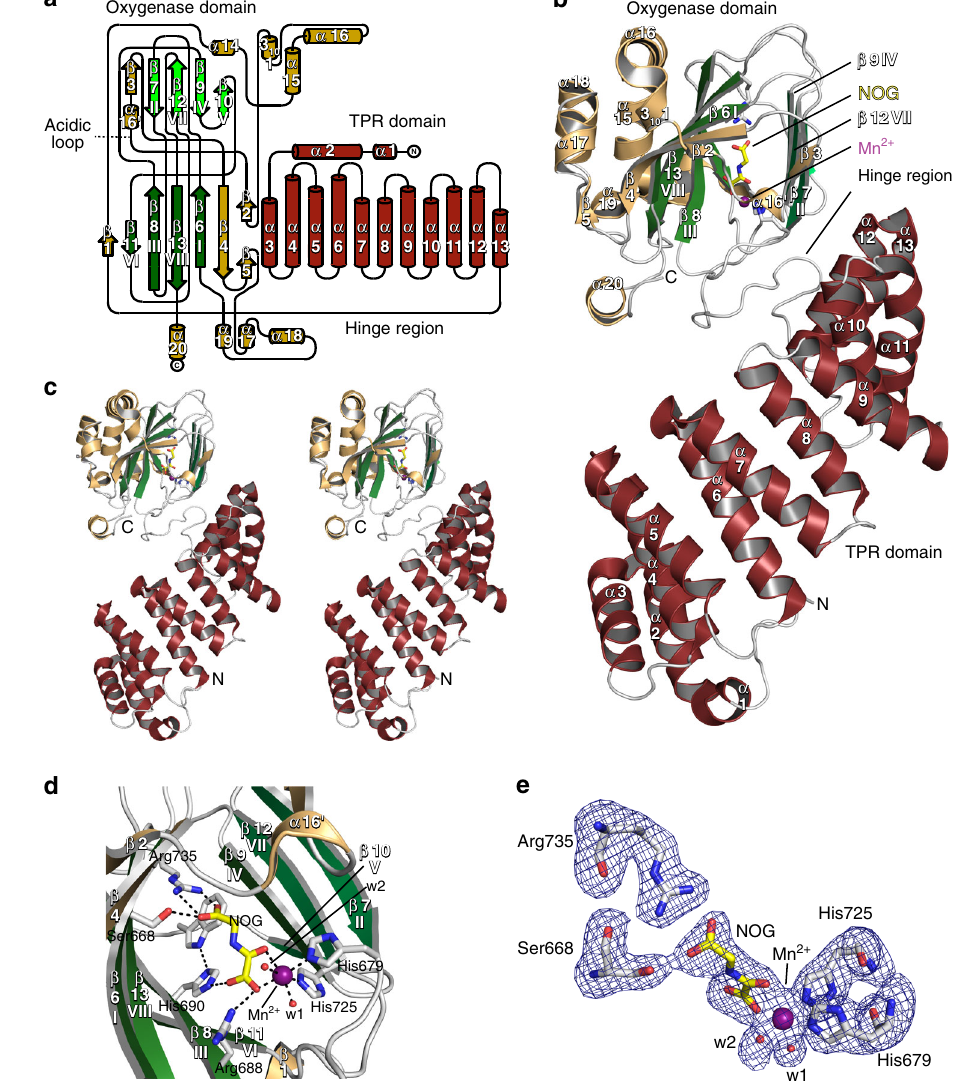
Fig. 2 Crystal structure of AspH-TPR-Ox reveals Fe(II)-binding involving only two residues. Color code: grey: His 6 -AspH 315 – 758 ; yellow: carbon-backbone of N -oxalylglycine (NOG); violet: Mn; red: oxygen; blue: nitrogen. w: water. a Topology diagram of human AspH 315 – 758 . b Overview of the AspH-TPR-Ox crystal structure. c Stereoview of the AspH-TPR-Ox crystal structure. d Close-up of the AspH-active site: Arg735 forms a salt bridge with the distal (C-5) carboxylate oxygens of NOG (2.4 and 3.1 Å) while Ser668 interacts with one oxygen lone pair through a hydrogen bond (2.7 Å). His690 is positioned to hydrogen bond to the C-1 carboxylate of NOG (2.8 Å). Mn(II) is bound to His679 (2.3 Å) and His725 (2.2 Å) of His 6 -AspH 315 – 758 and coordinates two water molecules (both 2.2 Å) as well as the C-1 (2.2 Å) and C-2 (2.5 Å) carbonyl oxygens of NOG. e Representative OMIT electron density map (mFo – DFc) contoured to 3 σ around NOG, Mn, water, and relevant AspH-active site residues are electron density at the active site corresponding to 18 of 99 – 116: -GKC 3 K D GLGEYTC 4 TC 5 LEGF-) and for a disul fi de linkage between Cys101 hFX and Cys110 hFX (Fig. 3e). Highly speci fi c interactions, including multiple protein – protein/peptide interac- tions with both AspH-Ox and TPR domains are apparent (Fig. 3b – d). The N-terminal region of hFX (aa 100 – 105) interacts with the AspH-Ox domain and the C-terminal region of hFX (aa 106 – 116) interacts with the TPR domain. Comparison of AspH structures with and without substrate implies that induced fi t involving substantial conformational changes during formation of the AspH-TPR-Ox:hFX protein:protein complex occurs; the distance between Leu433 on repeat 3 of the TPR domain to Pro756 of the oxygenase domain near the C-terminus is reduced from 20 to ~14 Å on substrate binding. This movement is